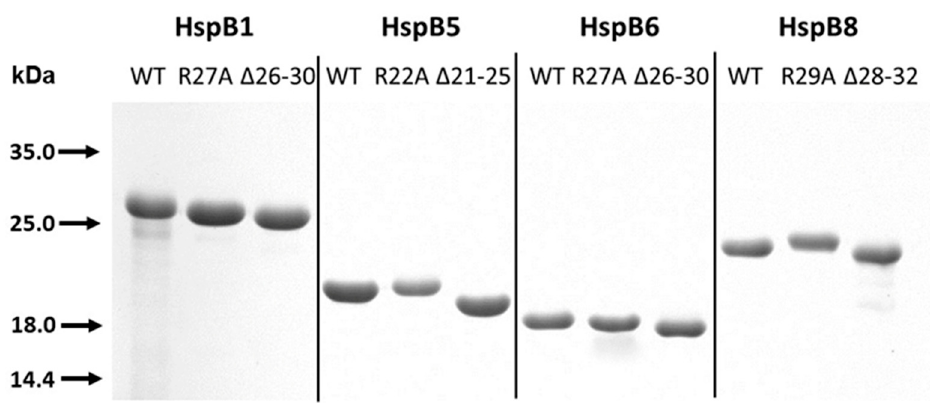
Figure 2. Sodium dodecyl sulfate (SDS) gel electrophoresis of the final preparation of the wild-type (WT) proteins and their mutants. About 1.5 µg of proteins were loaded on each track.